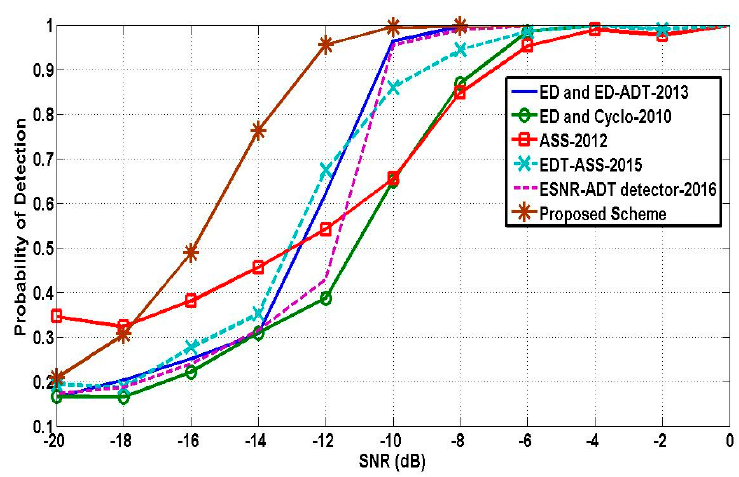
Figure 5. Network distribution using NetSim.